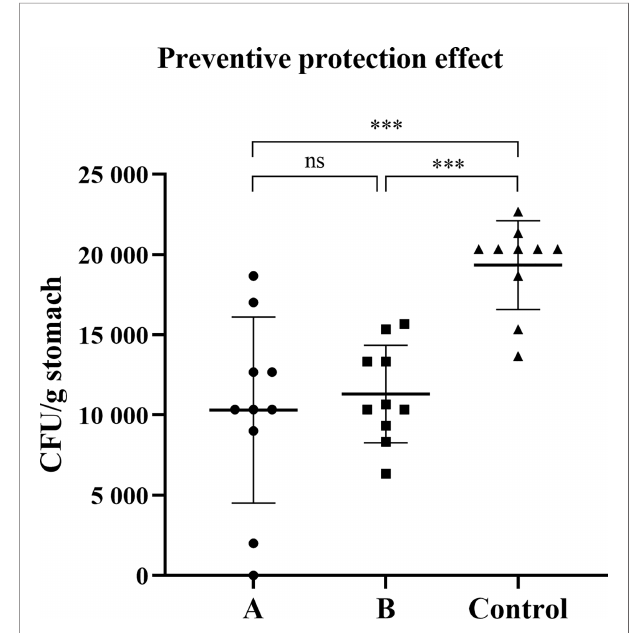
FIGURE 4 | Preventive immunization can induce protection against H. pylori challenge. Two weeks after the fi nal immunization, the mice were infected with live H. pylori SS1 bacteria. After eight weeks of the challenge, the colonization of H. pylori was con fi rmed by quantitative culture. The data were presented in the form of a scatter plot. Each symbol represents a mouse, and the horizontal line represented the mean ± SD, and differences between groups were tested using one-way ANOVA followed by Bonferroni ’ s multiple- pair comparison test. *** p < 0.001. ns p >0.05.